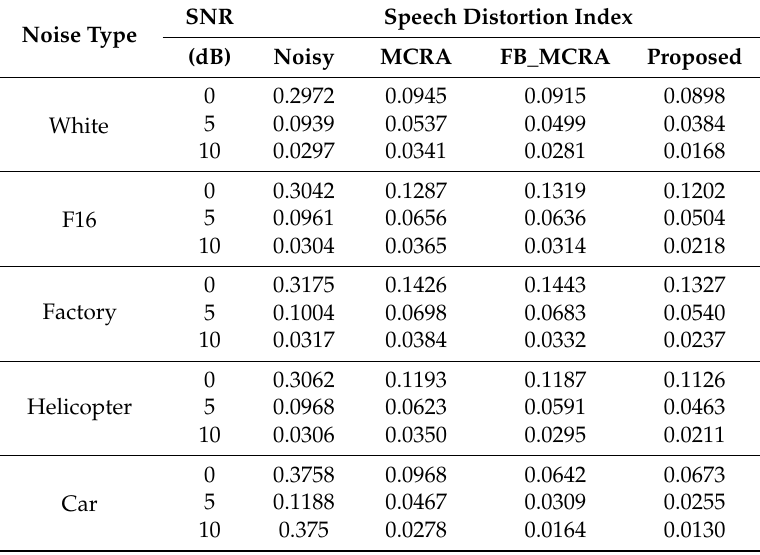
Comparisons of speech distortion index (SDI) for the denoised speech in various noise